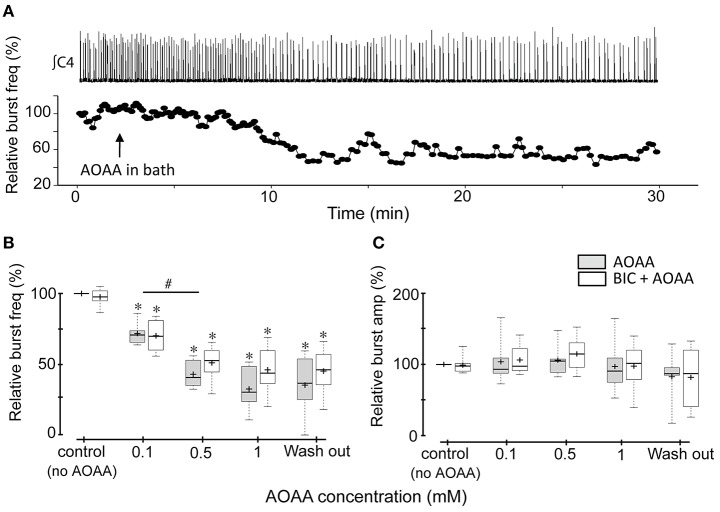
Effects of AOAA on rhythmic inspiratory-related activity recorded from the C4 ventral root of BSSC preparations. (A) Representative BSSC preparation showing the time course of how instantaneous frequency, calculated from the recording shown (∫C4, top trace), changes following bath application of 1 mM AOAA (indicated by the black arrow). The time scale of the nerve recordings and instantaneous frequency plots are matched. (B,C) Box plots of group data showing the dose-dependent effects on C4 inspiratory burst frequency (B) and amplitude (C) of AOAA bath-applied alone (n = 7), and, in a different group of BSSC preparations, in combination with bicuculline (3 μM, n = 8). The effect of bicuculline alone is presented in the control group data set. *Indicates significant difference (p < 0.05) compared to control (baseline), #Indicates significant difference (p < 0.05) between the indicated doses.